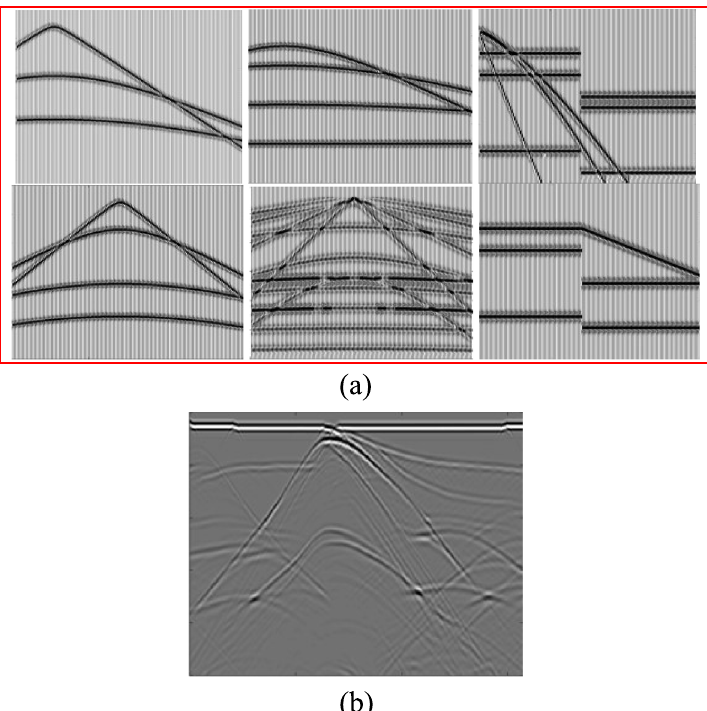
Fig. 5 Seismic data. a Partial synthetic seismic records; b Stacked profile measured by SEG/EAGE salt and overthrust